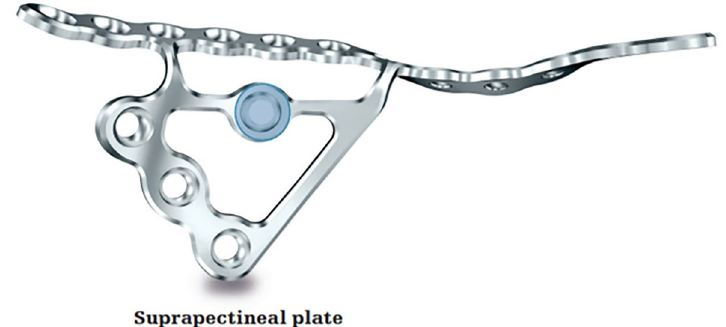
Figure 1. Image of anatomical suprapectineal quadrilateral surface